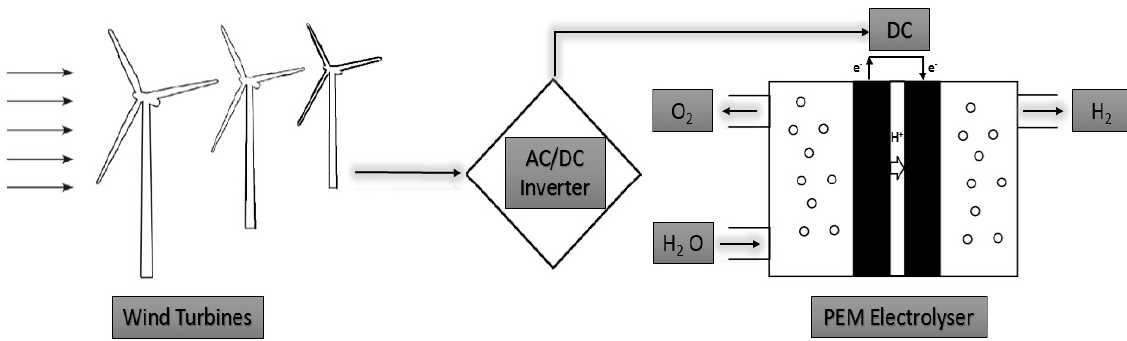
Figure 2. Schematic diagram of the adopted approach.